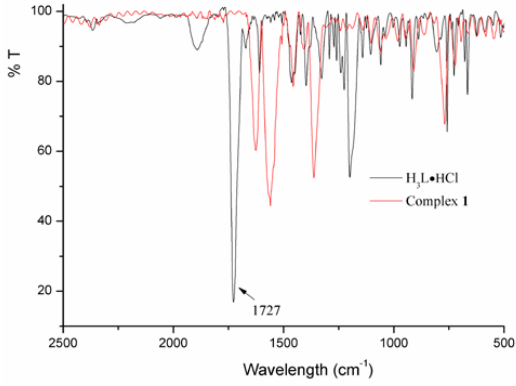
Figure 9. IR spectra of H 3 L·HCl and complex 1 .